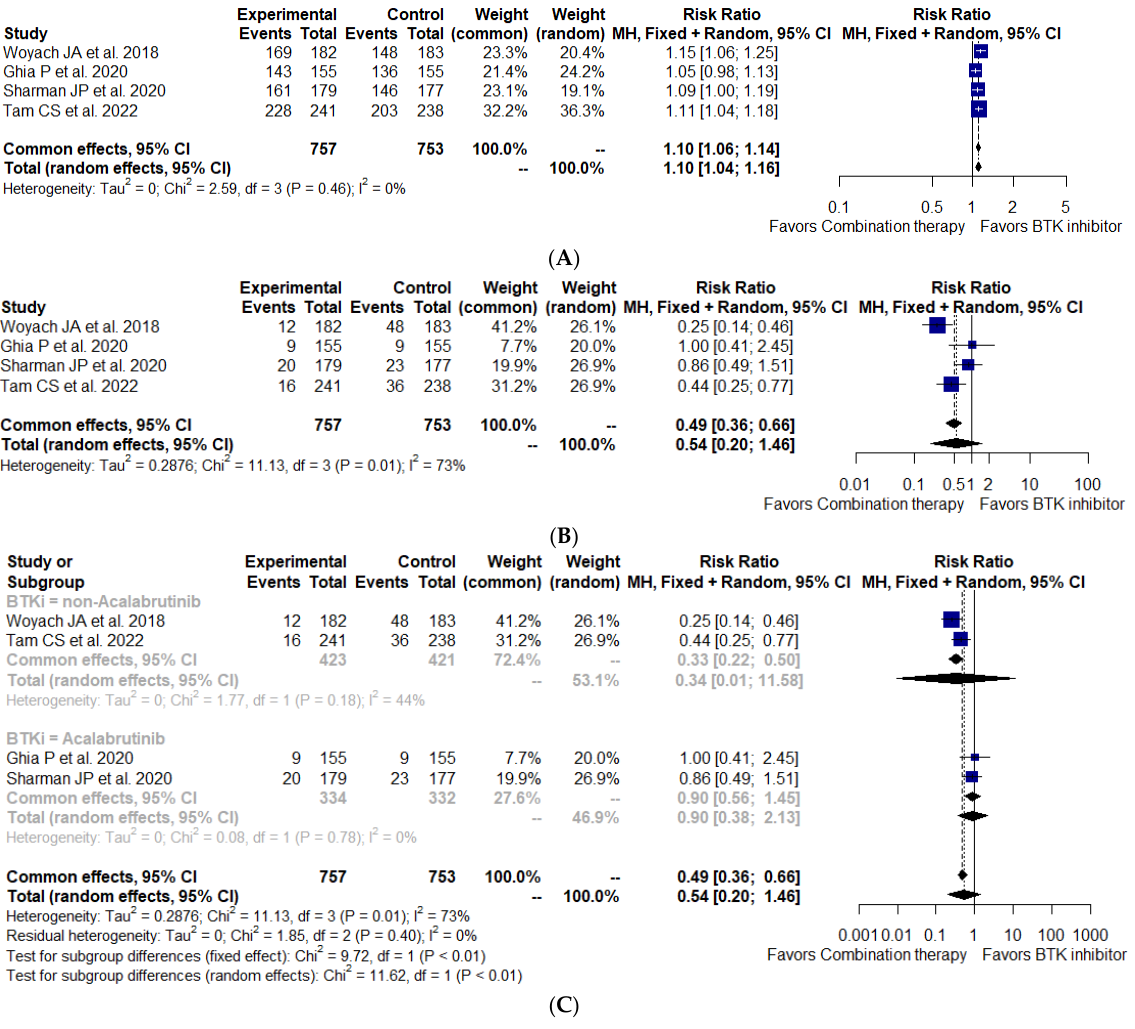
Figure 4. Pooled risk ratios for overall response ( A ), complete response ( B ), subgroup complete response ( C ) to treatment [25,30,42,45].